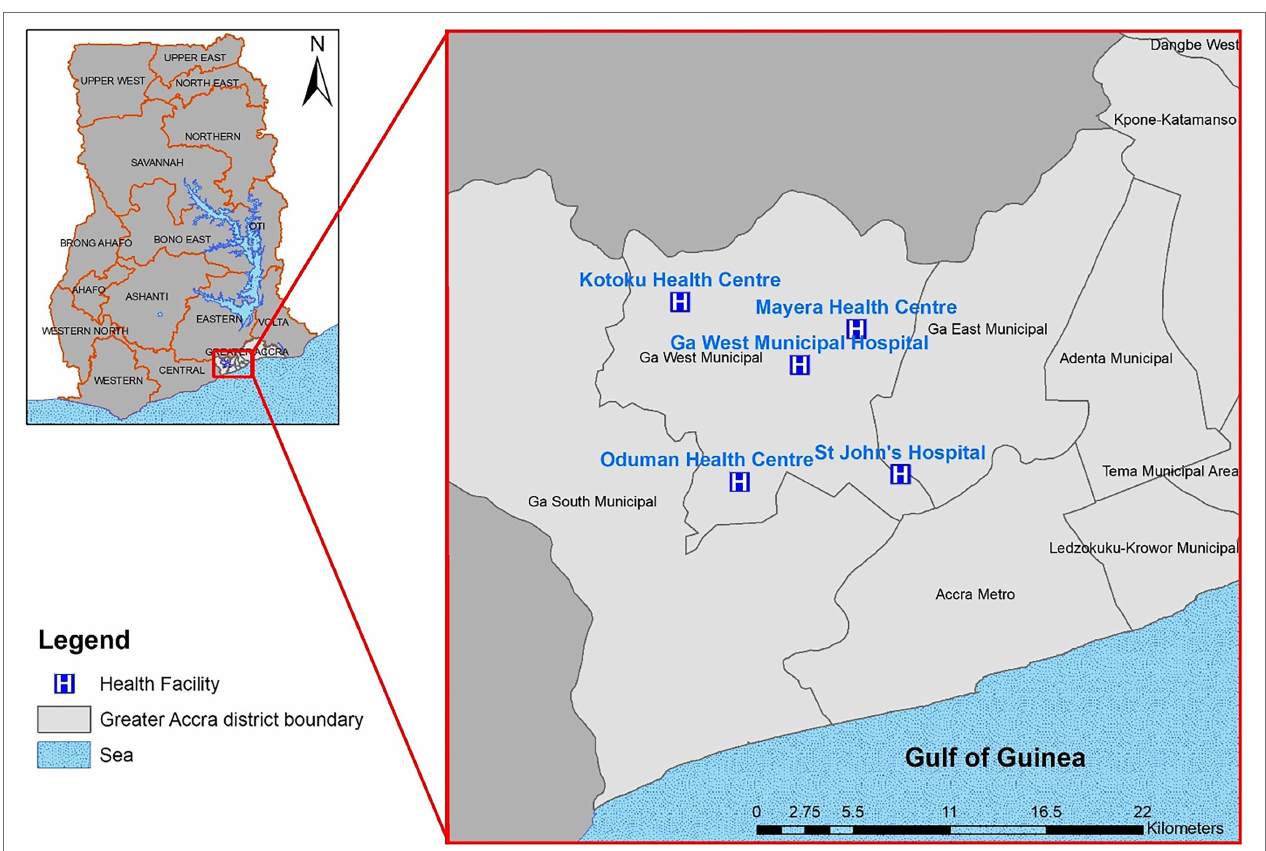
FIGURE 1 | A map showing the geographical locations of the participating health